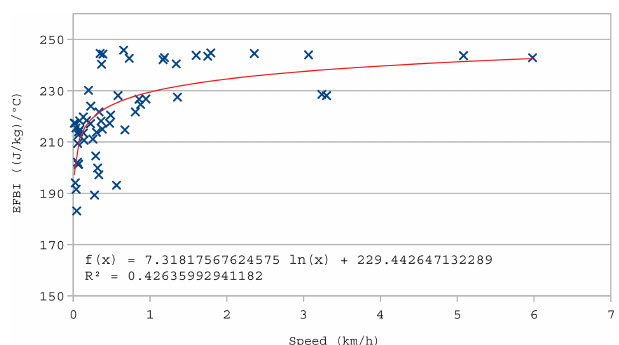
Figure 8. Scatter plot showing the maximum fire front speed and the values of the EFBI for each time step with a logarithmic trend